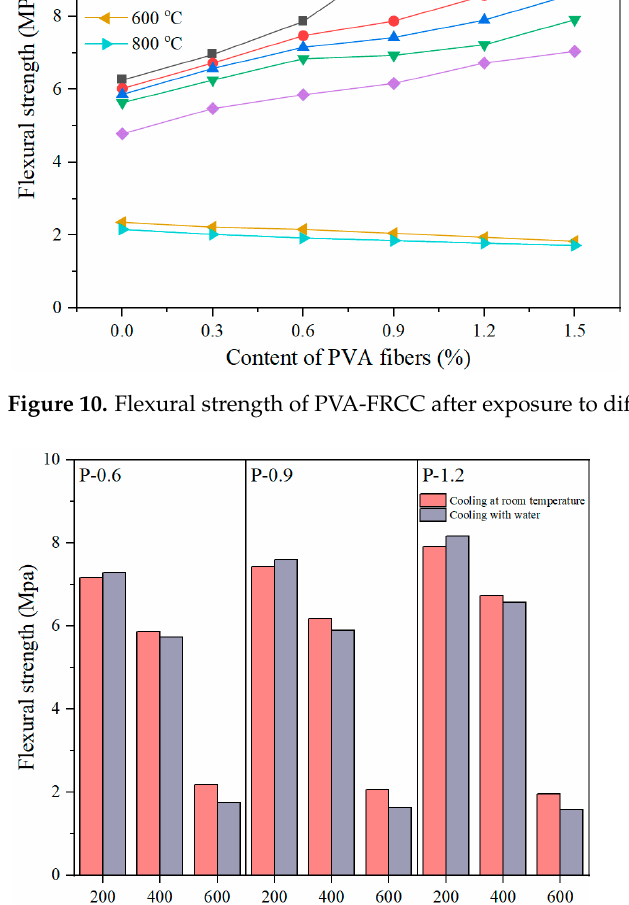
Figure 11. Flexural strength of PVA-FRCC specimens with different cooling methods.